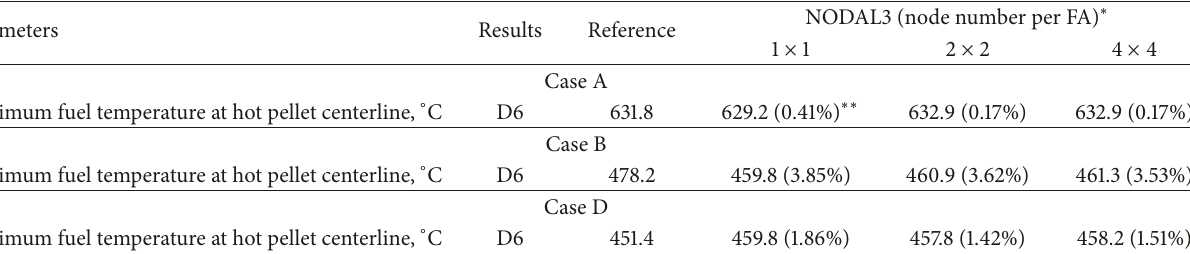
Table 8: Effect of radial node number per FA for transient hot pellet results in Cases A, B, and D.